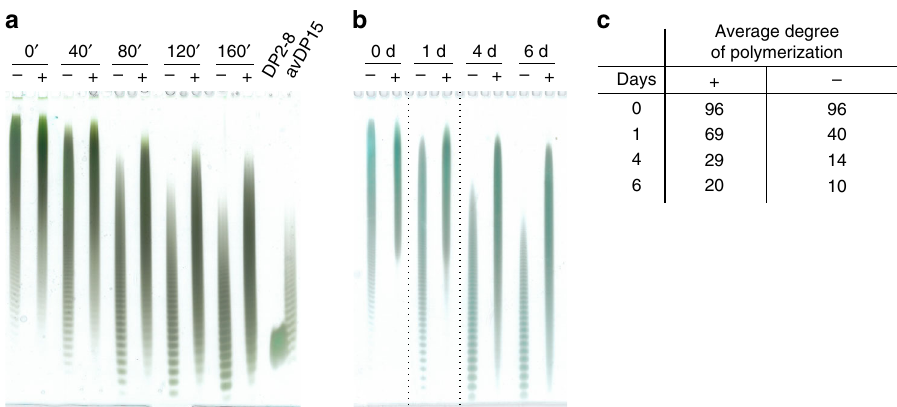
Fig. 3 Stability of NmA-CPS. a , b Non- O -acetylated ( − ) and enzymatically O -acetylated ( + ) capsule polymer was subjected to mild acidic hydrolysis in acetate buffer pH 4.7 at 80 °C a and phosphate buffer pH 7.0 at 45 °C b to simulate the hydrolysis conditions during vaccine manufacturing and prolonged storage in tropical climate, respectively. Samples were taken at the indicated time-points and the experiment was continued until an average degree of polymerization (avDP) of 15 was reached, which re fl ects the avDP used for the generation of anti-NmA glycoconjugate vaccines 17,68 . Partially hydrolyzed polymers were separated by PAGE and visualized by Alcian blue/silver staining. An oligomer mix with avDP15 and a mixture of short oligomers containing dimers to octamers (DP2 – 8) were used as markers 17 . Source data are provided as a Source Data fi le. c The avDP of O -acetylated ( + ) and non- O -acetylated ( − ) polymer was monitored by 31 P NMR under conditions corresponding to the experiment shown in b . According to a previously published method 19 , avDP values were calculated from 31 P NMR signals and expressed as ( P Int / P Ter ) + 1, where P Int is the molar concentration of the internal phosphate groups (phosphodiester groups) and P Ter is the molar concentration of terminal phosphate groups (phosphomonoester